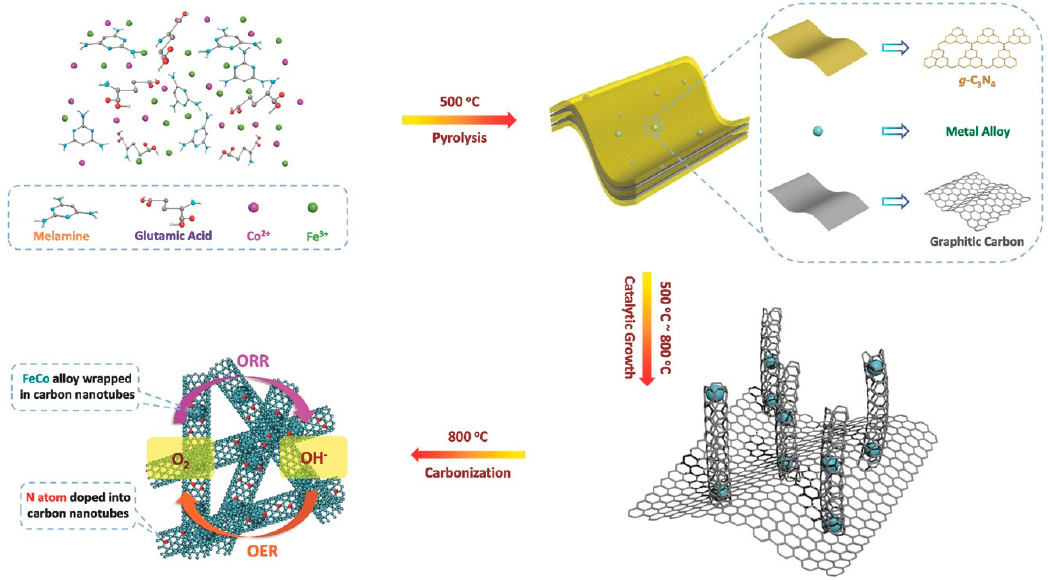
Figure 4. Illustration for the fabrication of N-doped graphitic carbon nanotube (N-GCNT)/FeCo bifunctional hybrids through the temperature-programed carbonization process, reproduced with permission from [42]. Copyright Wiley, 2017.